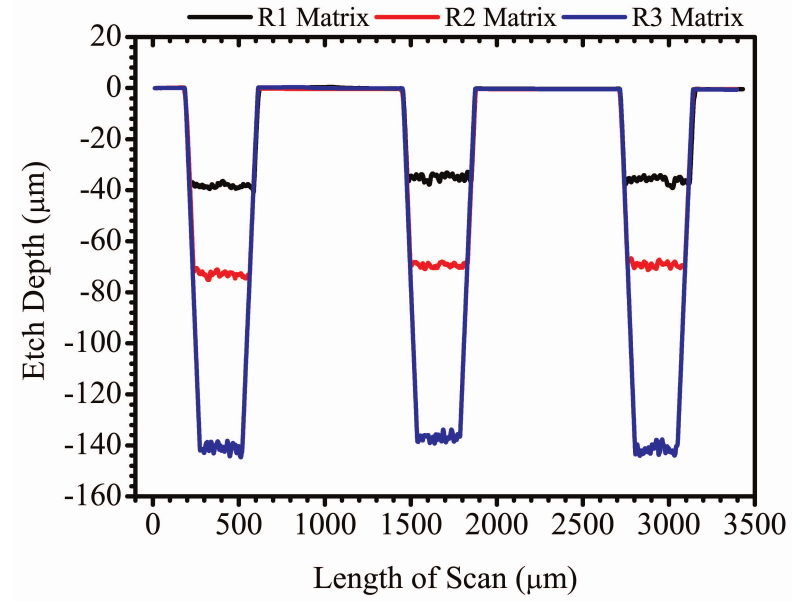
Figure 8. A plot showing the surface profilometer line scans across the matrices of the 3D multi-depth reservoir micromodel shown in Figure 7a. The black, red, and blue traces correspond to the profiles of reservoirs R1, R2, and R3,